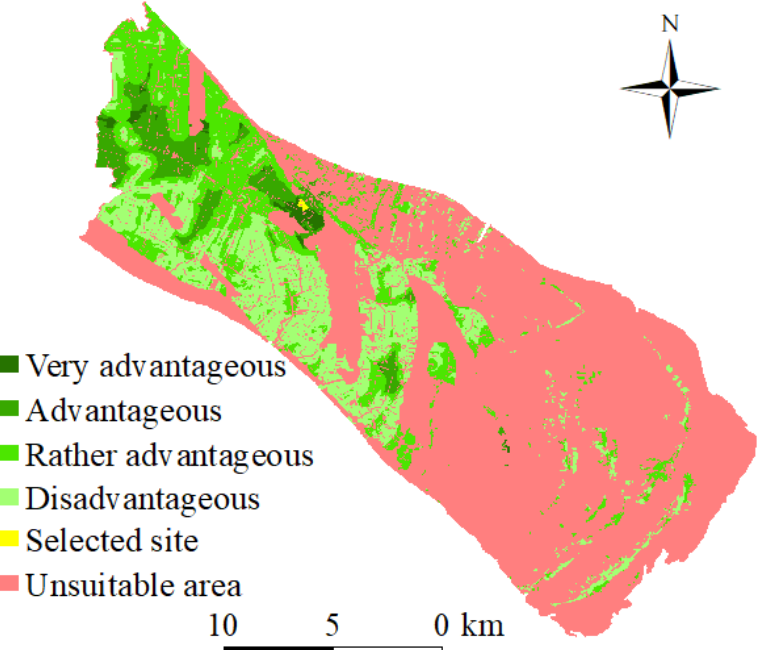
Figure 7. Landfill suitability map and selected site in the study area.